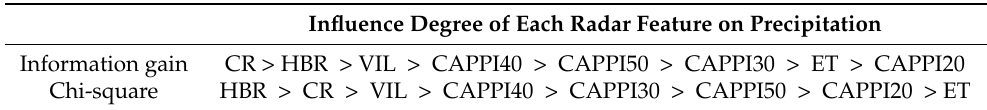
Table 4. Ranking of influence of each radar product on precipitation.